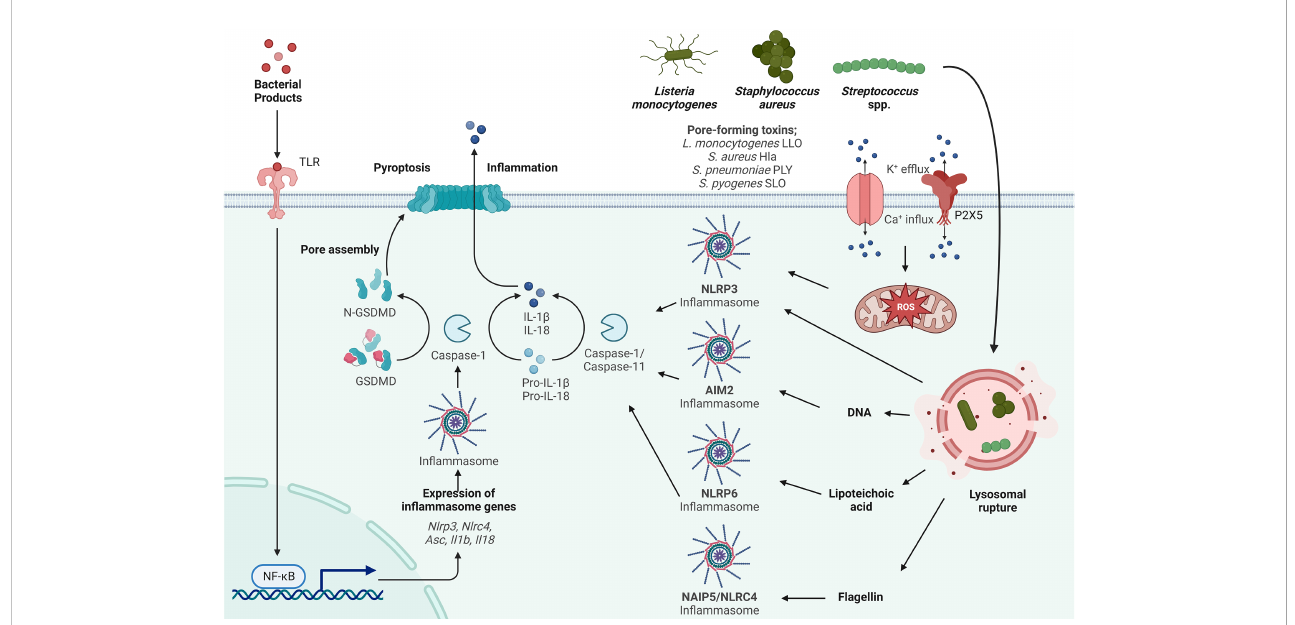
FIGURE 1 In fl ammasome activation by Gram-positive bacteria. Activation of the in fl ammasome typically starts by priming (signal 1) through TLR activation resulting in the transcriptional upregulation of in fl ammasome components such as Asc, Nlrp3, Nlrc4, IL-1 b and IL-18. Activation (signal 2) is initiated by a variety of PAMPs from Listeria monocytogenes , Streptococcus spp. and Staphylococcus spp., such as lipoteichoic acid (LTA), DNA and fl agellin. LTA activates the NLRP6 in fl ammasome, DNA activates the AIM2 in fl ammasome and fl agellin activates the NLRC4 in fl ammasome. Listeria monocytogenes , Streptococcus spp. and Staphylococcus spp. express pore forming toxins (PFTs) that are inserted into the plasma membrane to facilitate access to the host cytosol. K+ ef fl ux and Ca+ in fl ux through these pores and the P2X5 receptor (a member of the P2X purinergic receptor family of ligand-gated cation channels) results in activation of the NLRP3 in fl ammasome. In addition to PAMP activation and ion fl uxes, the in fl ammasome is also activated by damage- associated molecular patterns (DAMPs) such as lysosomal rupture and production of mitochondrial reactive oxygen species (mtROS) that activates the NLRP3 in fl ammasome. Sensing of PAMPs and DAMPs by the NLR initiates the formation of the in fl ammasome consisting of ASC and Caspase-1, which in turn cleaves pro-IL-1 b and pro-IL-18. Gasdermin D (GSDMD) is also cleaved and inserts into the membrane, forming pores leading to the release of